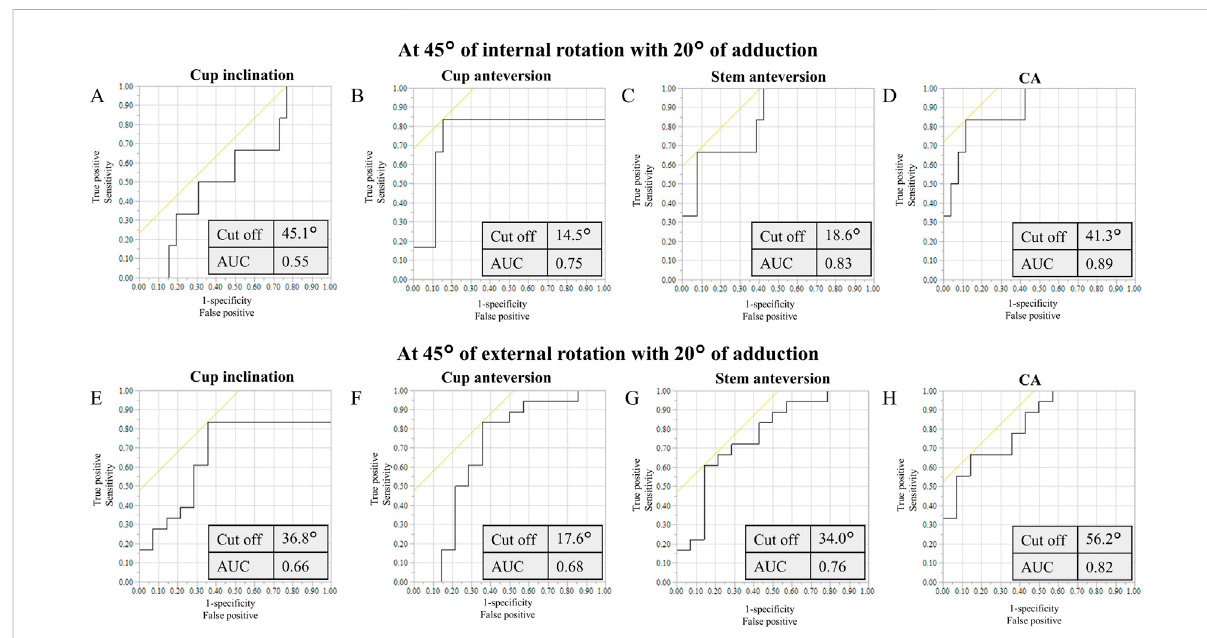
FIGURE 5 ROC curves ofthecupinclination (A) , cupanteversion (B) ,stem anteversion (C) ,and CA (D) to preventfrom anterior impingementatmaximum hip fl exion with simulated 45 ° internal rotation and 20 ° adduction. ROC curves of the cup inclination (E) , cup anteversion (F) , stem anteversion (G) , and CA (H) to prevent fromposteriorimpingementatmaximumhipextension withsimulated 45 ° external rotation and20 ° adduction,ROC: receiver operating characteristic, CA: combined anteversion, AUC: area under the curve.